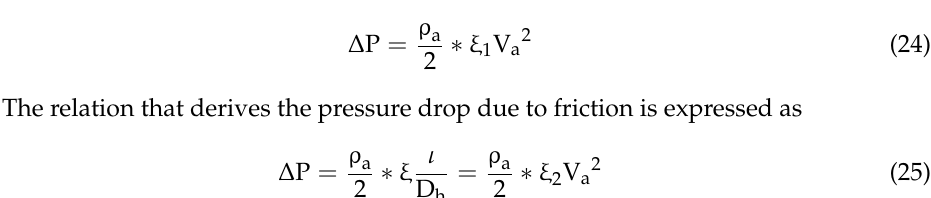
Figure 9. Analytical proposed LPTN model of 225 kW HSPMSM with FACAVS. Table 5. Calculated air coolant′s parameters.